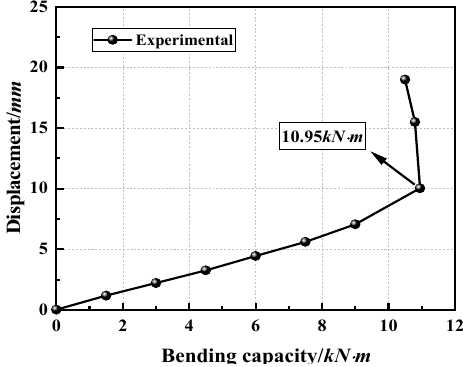
Figure 10. Bending bearing capacity of a horizontal bar.